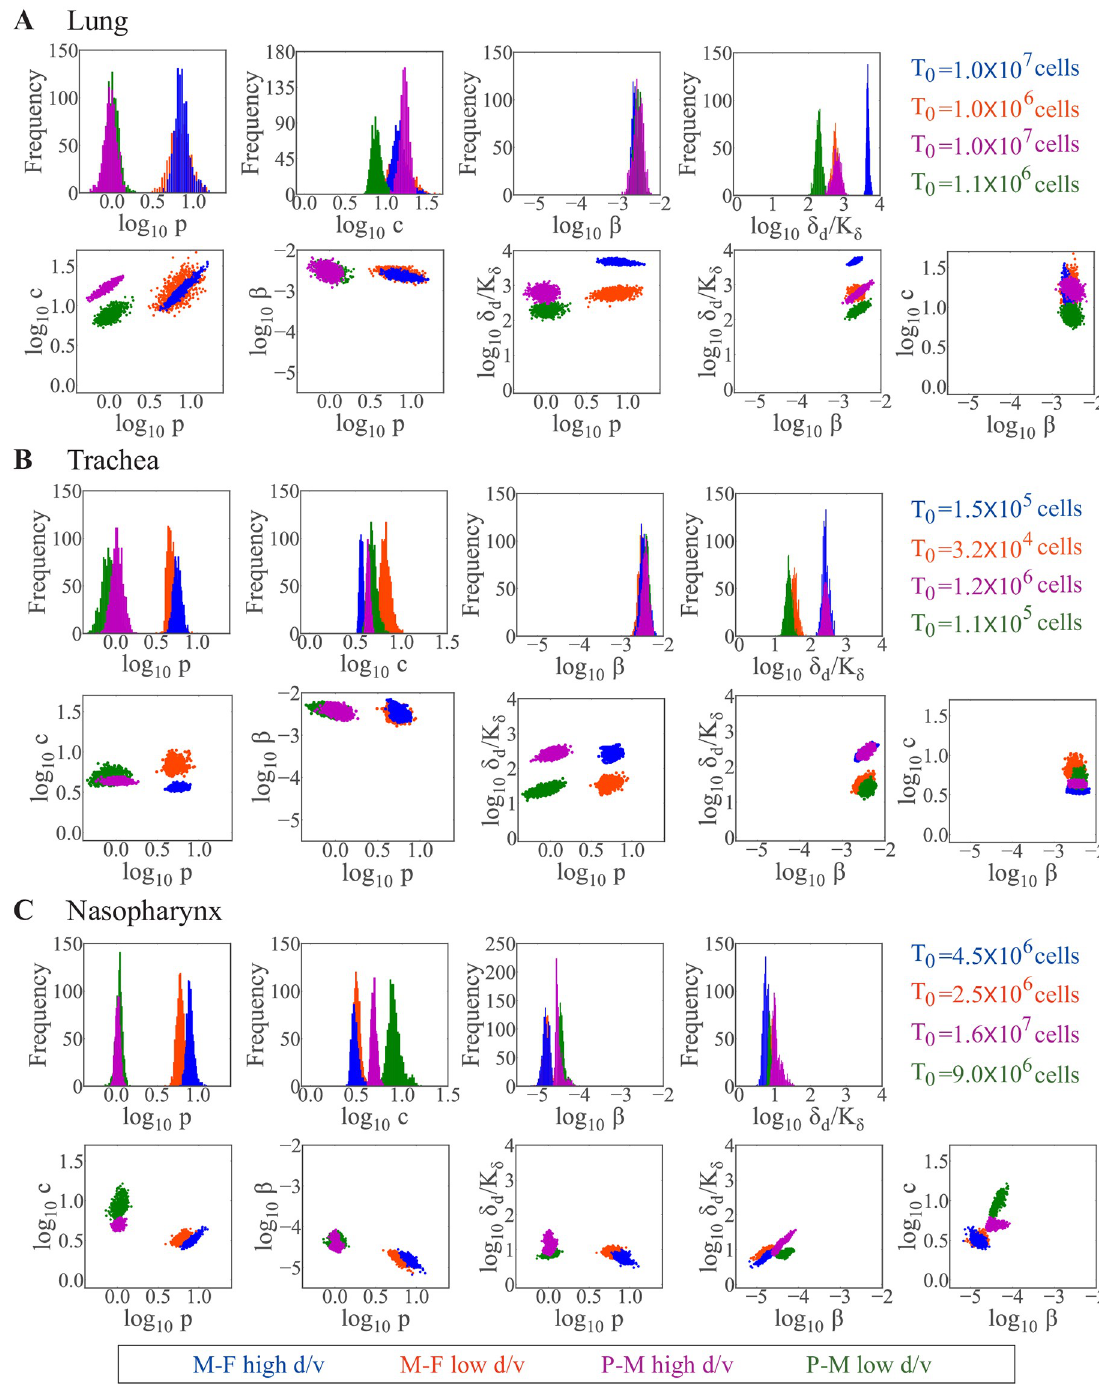
Fig 3. Strain- and dose-dependent parameters in the lung, trachea, and nasopharynx. Comparison of parameter histograms and ensembles resulting from fitting the model (Eqs (3)–(6)) to estimated viral loads from the lung (Panel A), trachea (Panel B) or nasopharynx (Panel C) of mice infected with the rSeV-luc(M-F � ) virus (“M-F”) at high d/v (blue) or low d/v (orange), or infected with the rSeV-luc (P-M) virus (“P-M”) at high d/v (magenta) or low d/v (green). Parameters shown are virus production ( p ), virus clearance ( c ), virus infection ( β ), and infected cell clearance ( δ d / K δ ). Additional histograms and ensemble plots are in Figs E-G in S1 Text.